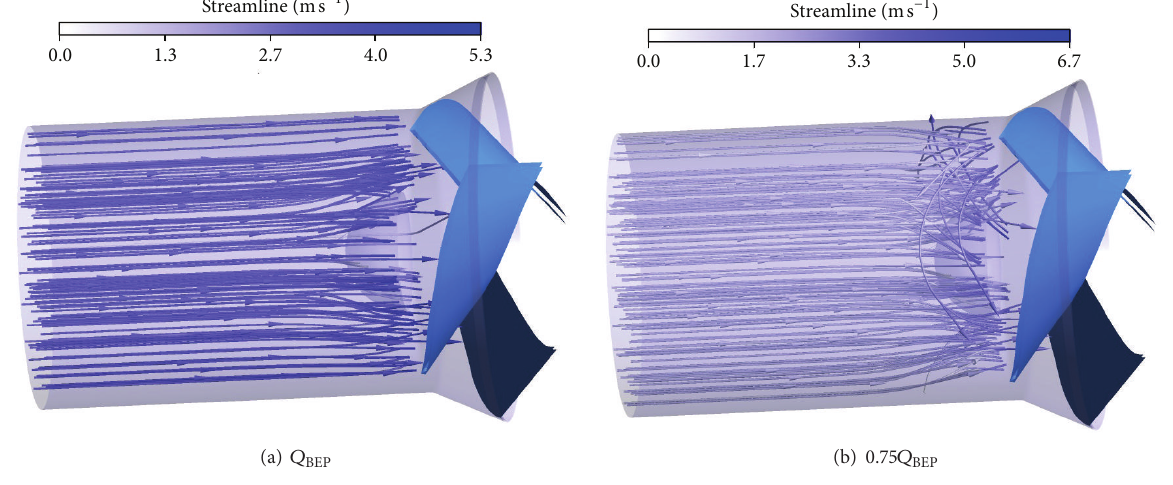
Figure 6: Velocity streamline at the upstream of the impeller.